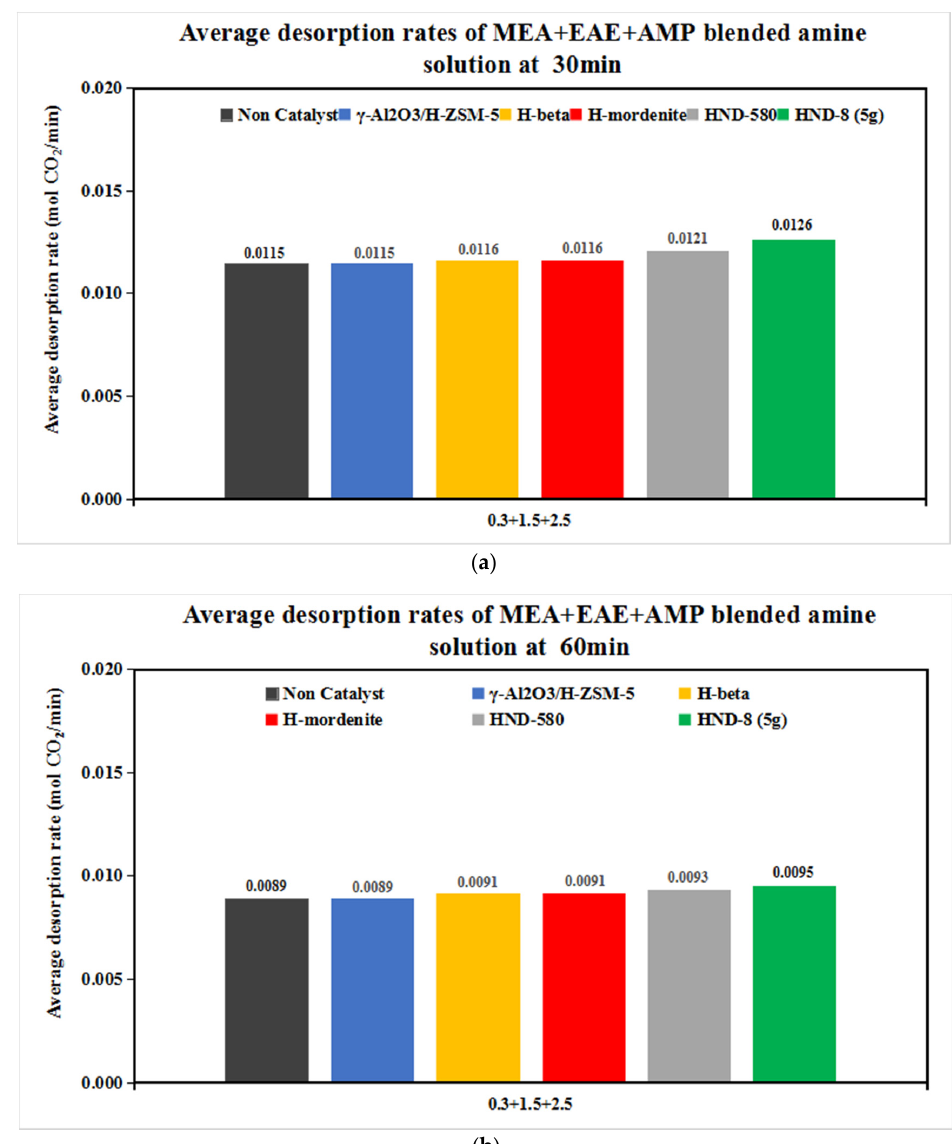
Figure 7. The CO 2 desorption profiles of MEA + EAE + AMP at 0.3 + 1.5 + 2.5 mol/L with catalysts of 0.3 + 1.5 + 2.5 mol/L.